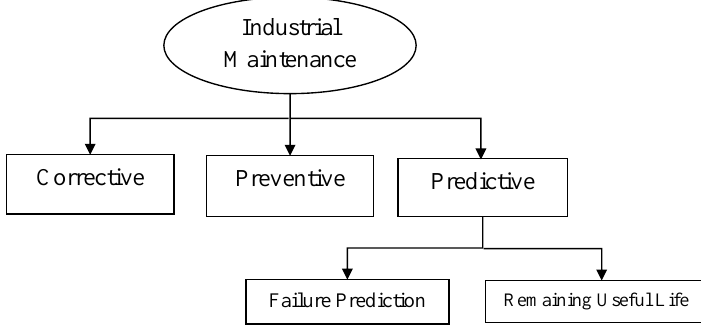
Figure 2. Classification of automatic industrial maintenance